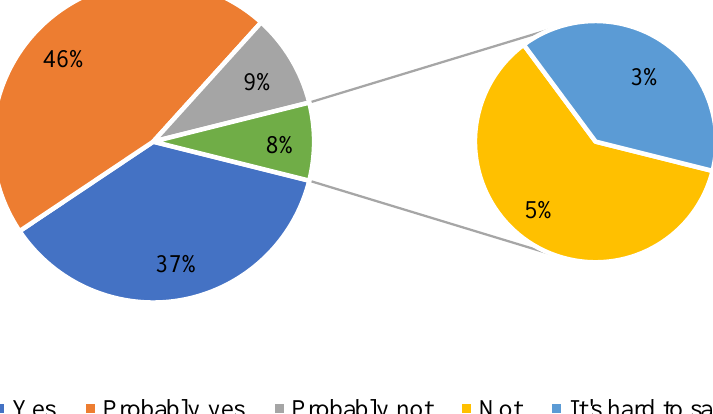
Figure 2. Characteristics of the respondents in terms of using a mobile phone while walking on the street or